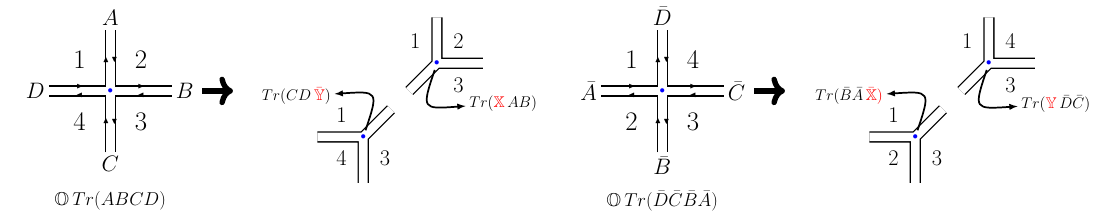
Figure 24 . Splitting vertices with couplings (cid:12)